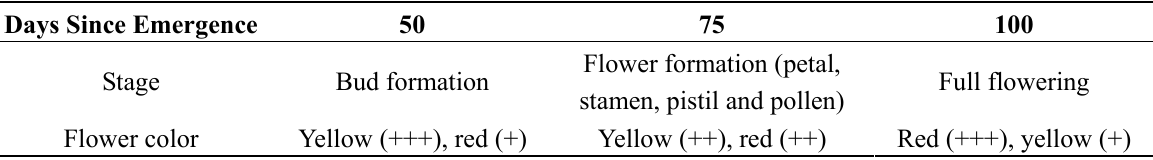
Table 2. Physical characteristics of Carthamus tinctorius during floral development [8]. Days Since Emergence 50 75 100 Flower formation (petal, Full flowering Stage Bud formation stamen, pistil and pollen) Flower color Yellow (+++), red (+) Yellow (++), red (++) Red (+++), yellow (+) +: week intensity of red and yellow color; ++: moderate intensity of red and yellow color; +++: high intensity of red and yellow